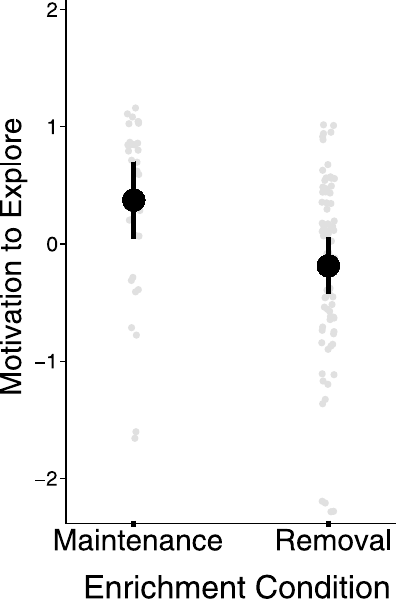
Figure 3. Composite measure of exploration motivation by enrichment condition. Removing enrichment led to a significant reduction in the motivation to explore, p , .01 (light gray dots: individual data points; large black dots: average response by condition; black vertical lines: 95% Confidence Interval).